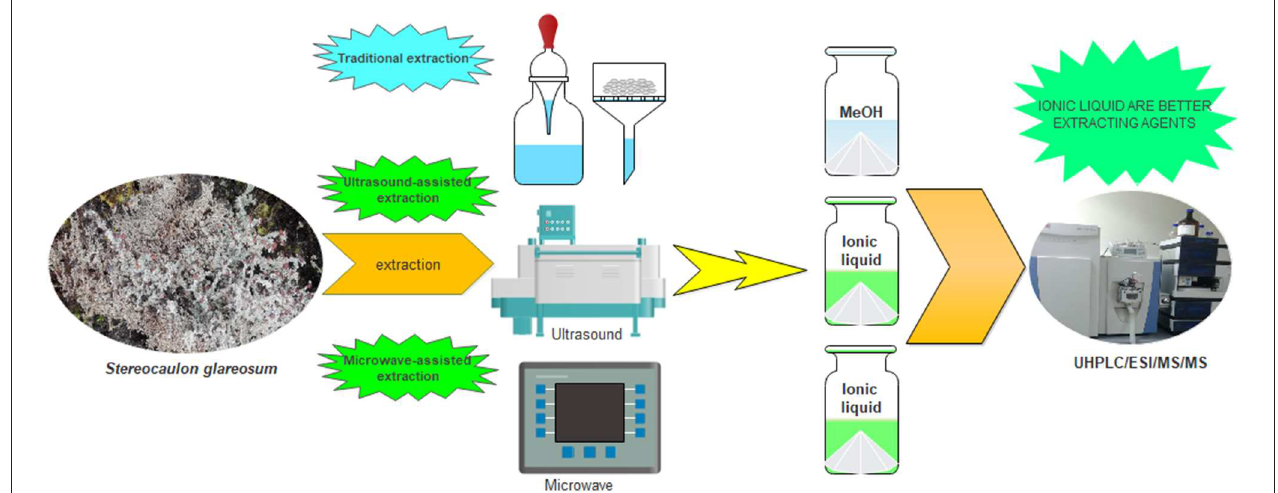
FIGURE 1 | Scheme used in the extraction process.